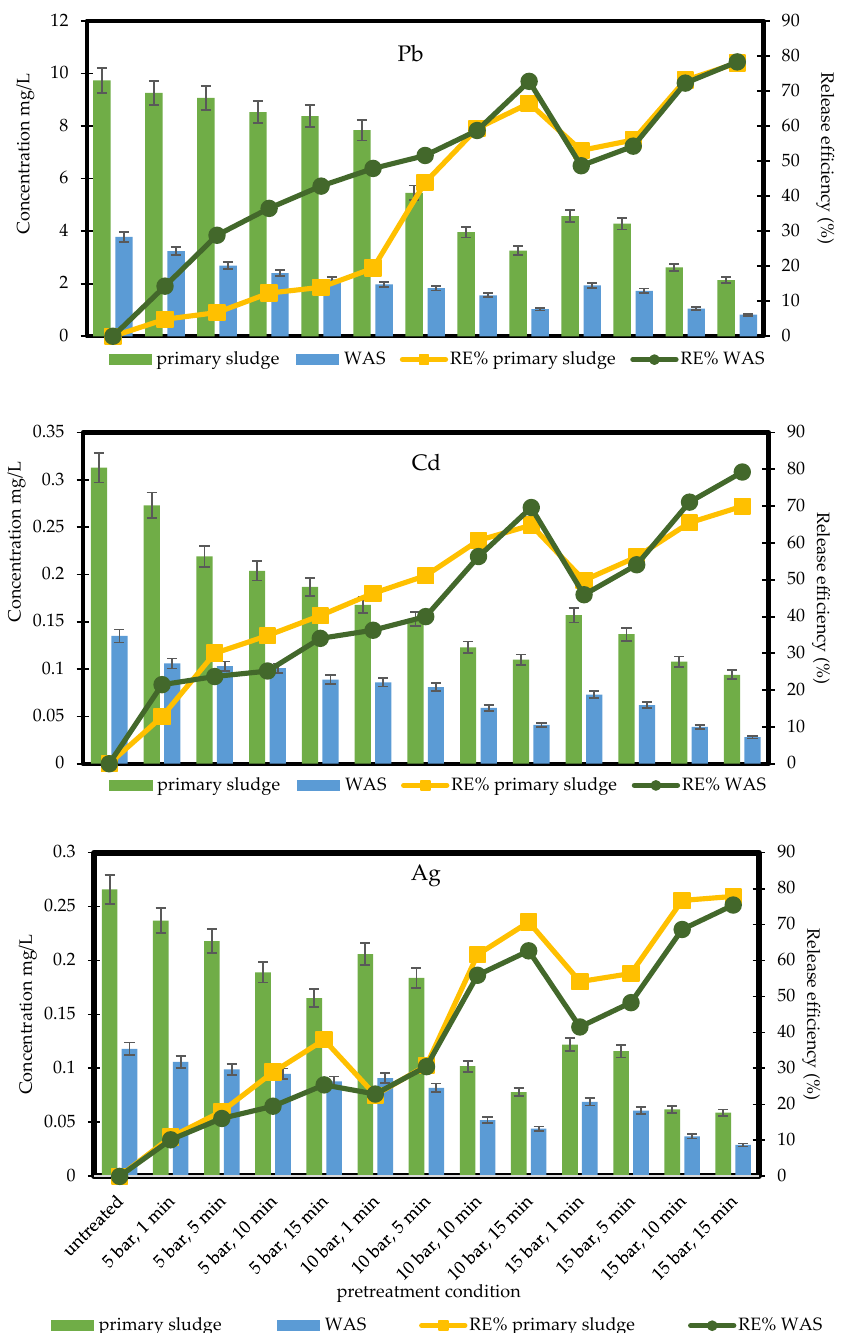
Figure 1. E ff ect of steam explosion on release e ffi ciency of heavy metals in the primary sludge (PS) and Figure 1. Effect of steam explosion on release efficiency of heavy metals in the primary sludge (PS) and waste-activated sludge waste-activated sludge (WAS).